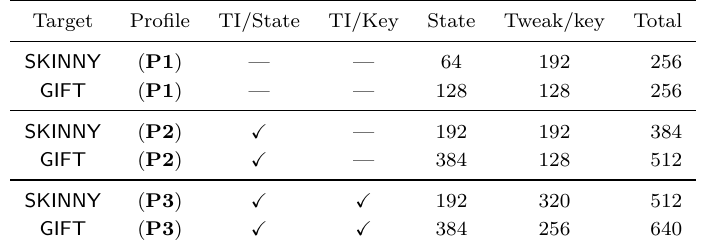
Table 2: Number of registers for implementing SKINNY and GIFT in different profiles.